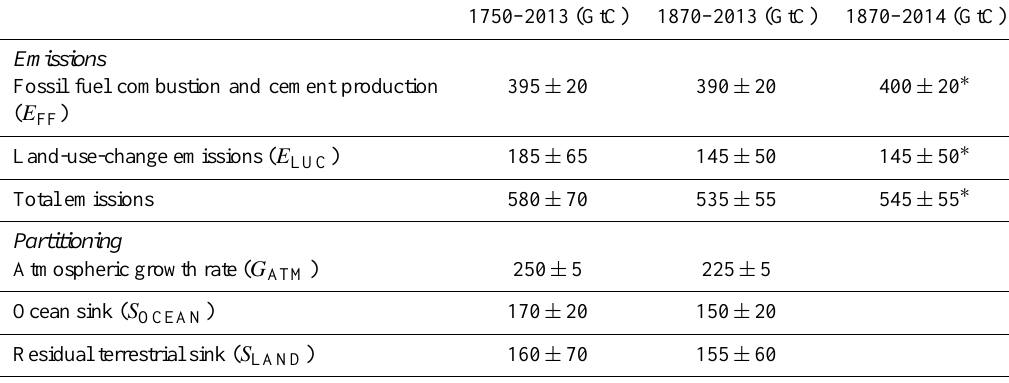
Table 10. Cumulative CO 2 emissions for the periods 1750–2013, 1870–2013, and 1870–2014 in gigatonnes of carbon. All uncertainties are reported as ± 1 σ . All values are rounded to the nearest 5GtC as in Stocker et al. (2013b), reflecting the limits of our capacity to constrain cumulative estimates. Thus some columns will not exactly balance because of rounding